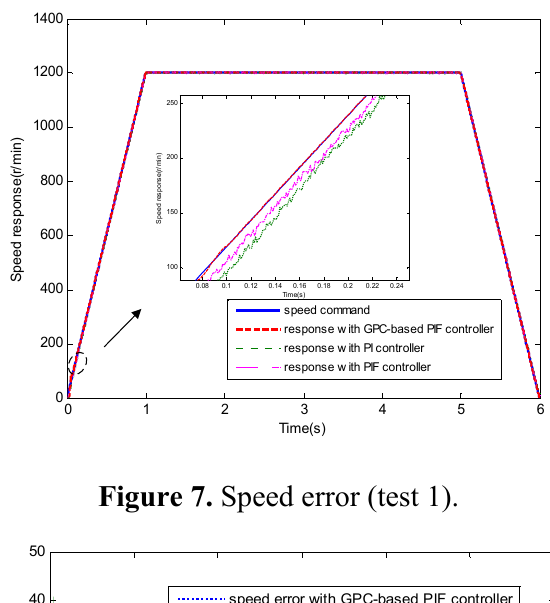
Figure 6. Speed response (test 1).